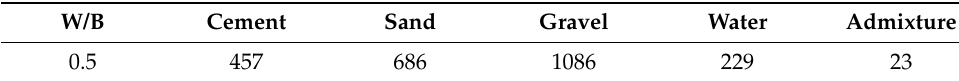
Figure 1. Schematics of FRP grid/concrete/VRHP mortar composites (Units: mm). Table 3. Mix proportion of concrete (kg/m 3 ).